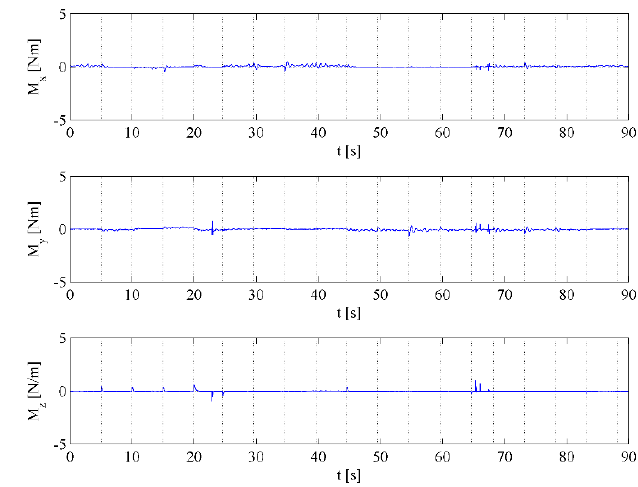
Figure 13. Desired torques of the quadrotor when using the PD controller.